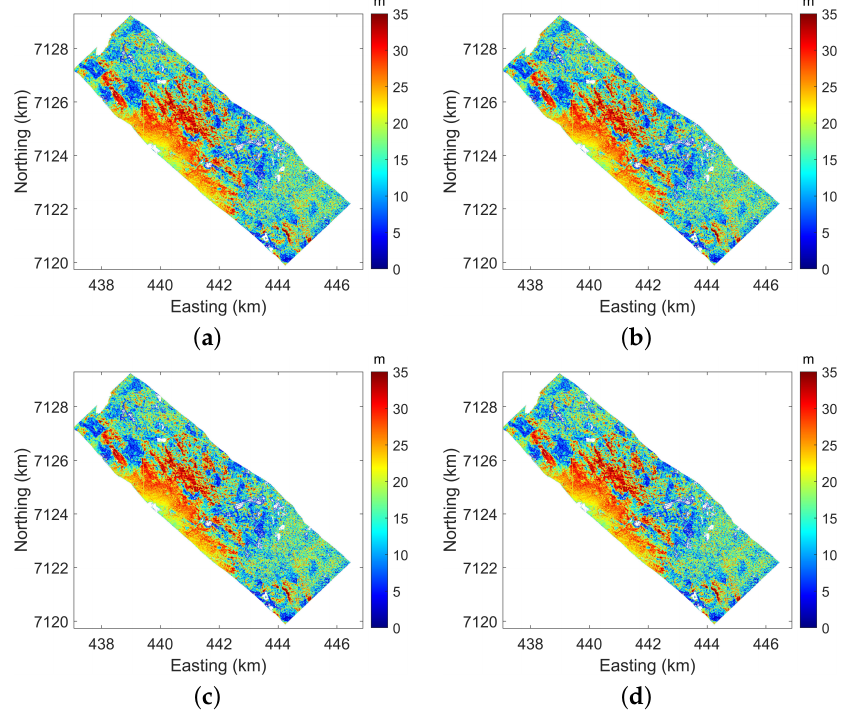
Figure 11. The single baseline inversion results of L-band in different configurations. The color ramps = [0, 35] m. ( a ) TSIA + EBCR + LUT. ( b ) TSIA + IEBCR + ILUT. ( c ) TSIA + EBCR + ILUT. ( d ) TSIA + IEBCR + LUT.